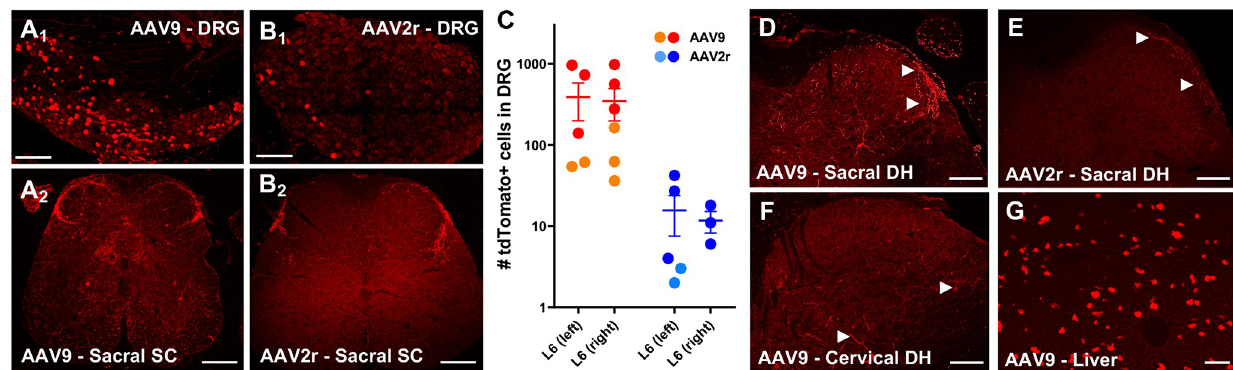
Fig 4. AAV9 and AAV2retro-mediated transduction following intracolonic injections. A and B, tdTomato labeling in L6 DRG and sacral spinal cord was more abundant in AAV9-injected compared to AAV2retro injected animals from cohort 1. The images in A1 and B1 represent a maximum intensity projection of four stitched 3D stacks spanning the entire ganglion (collected with a 3 μ m z-step). Scale bars: A1 and B1, 150 μ m; A2 and B2, 100 μ m. C, Quantitative analysis of tdTomato expressing L6 DRG neurons from cohort 1 (circles) and cohort 2 (squares). D-E, Sacral spinal cords from cohort 2 showed labelling of afferent fibers and a few neurons in the spinal cord, consistent with the previously observed pattern (D, E). Scale bar = 100 μ m. F-G , The presence of tdTomato labelled fibers and cells in cervical spinal cord as well as cells of the liver provides evidence for systemic distribution of AAV9 (F, G). Scale bars: F, 100 μ m; G, 150 μ